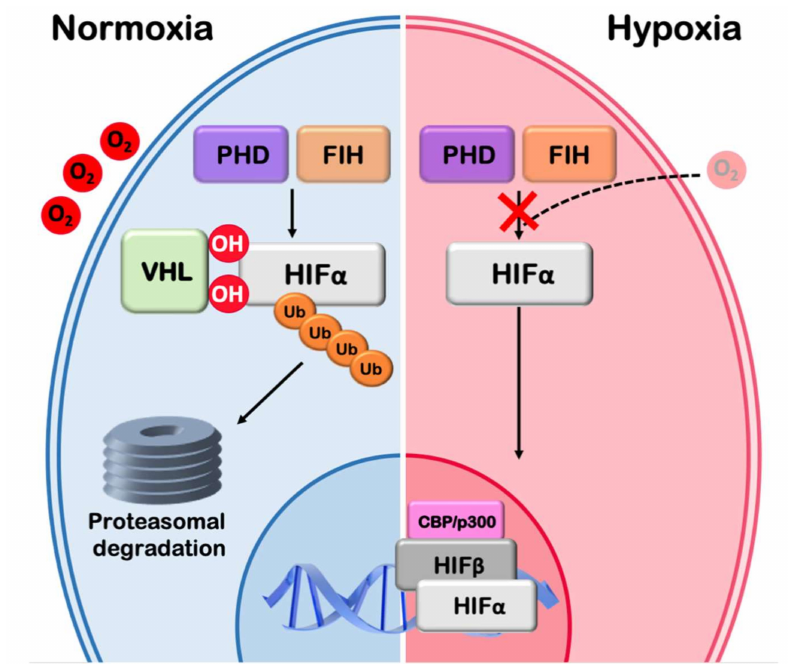
Figure 2. The hypoxic signaling pathway. The hypoxic signaling pathway: Under normoxia HIF α is hydroxylated by PHD and FIH hydroxylases in an oxygen dependent manner. Hydroxylation by PHD leads to pVHL and E3 ubiquitin ligase recruitment, ubiquitination of HIF α and subsequent proteasomal degradation. Hydroxylation by FIH leads to transcriptional inactivation. Low O 2 inactivates both PHD and FIH hydroxylases, HIF α is stabilized, enters the nucleus, dimerizes with HIF-1 β (ARNT), binds to specific DNA elements (hypoxia responsive elements) and, in association with transcription coactivators such as CBP / p300, stimulates the transcription of hypoxia target